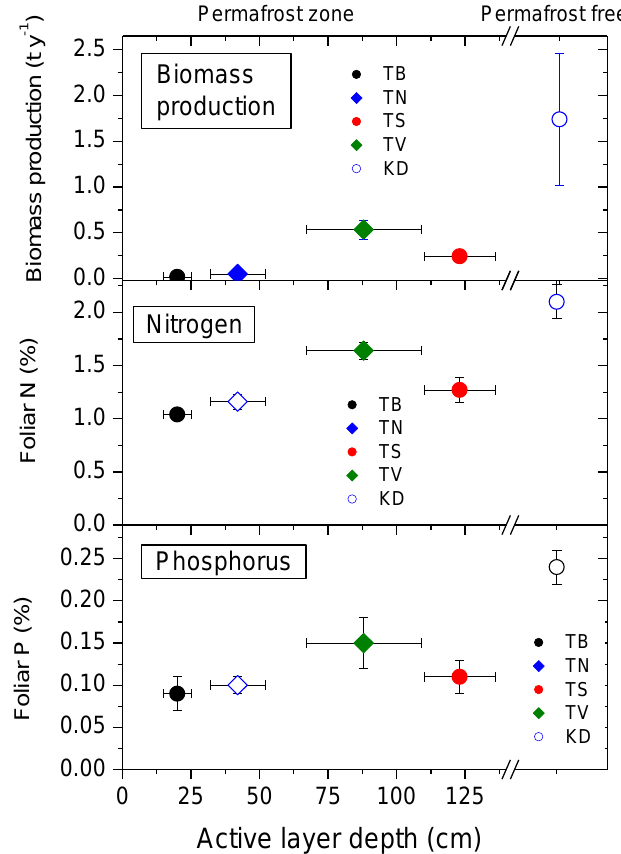
Figure 2. Stand-specific stem biomass production rates of Larix gmelinii trees for the last five years prior to collection year, and foliar N and P concentrations in mature needles (August) in relation to soil active layer depth of the four sites of the permafrost terrain and permafrost-free site. Mean and standard deviation of three replicates.